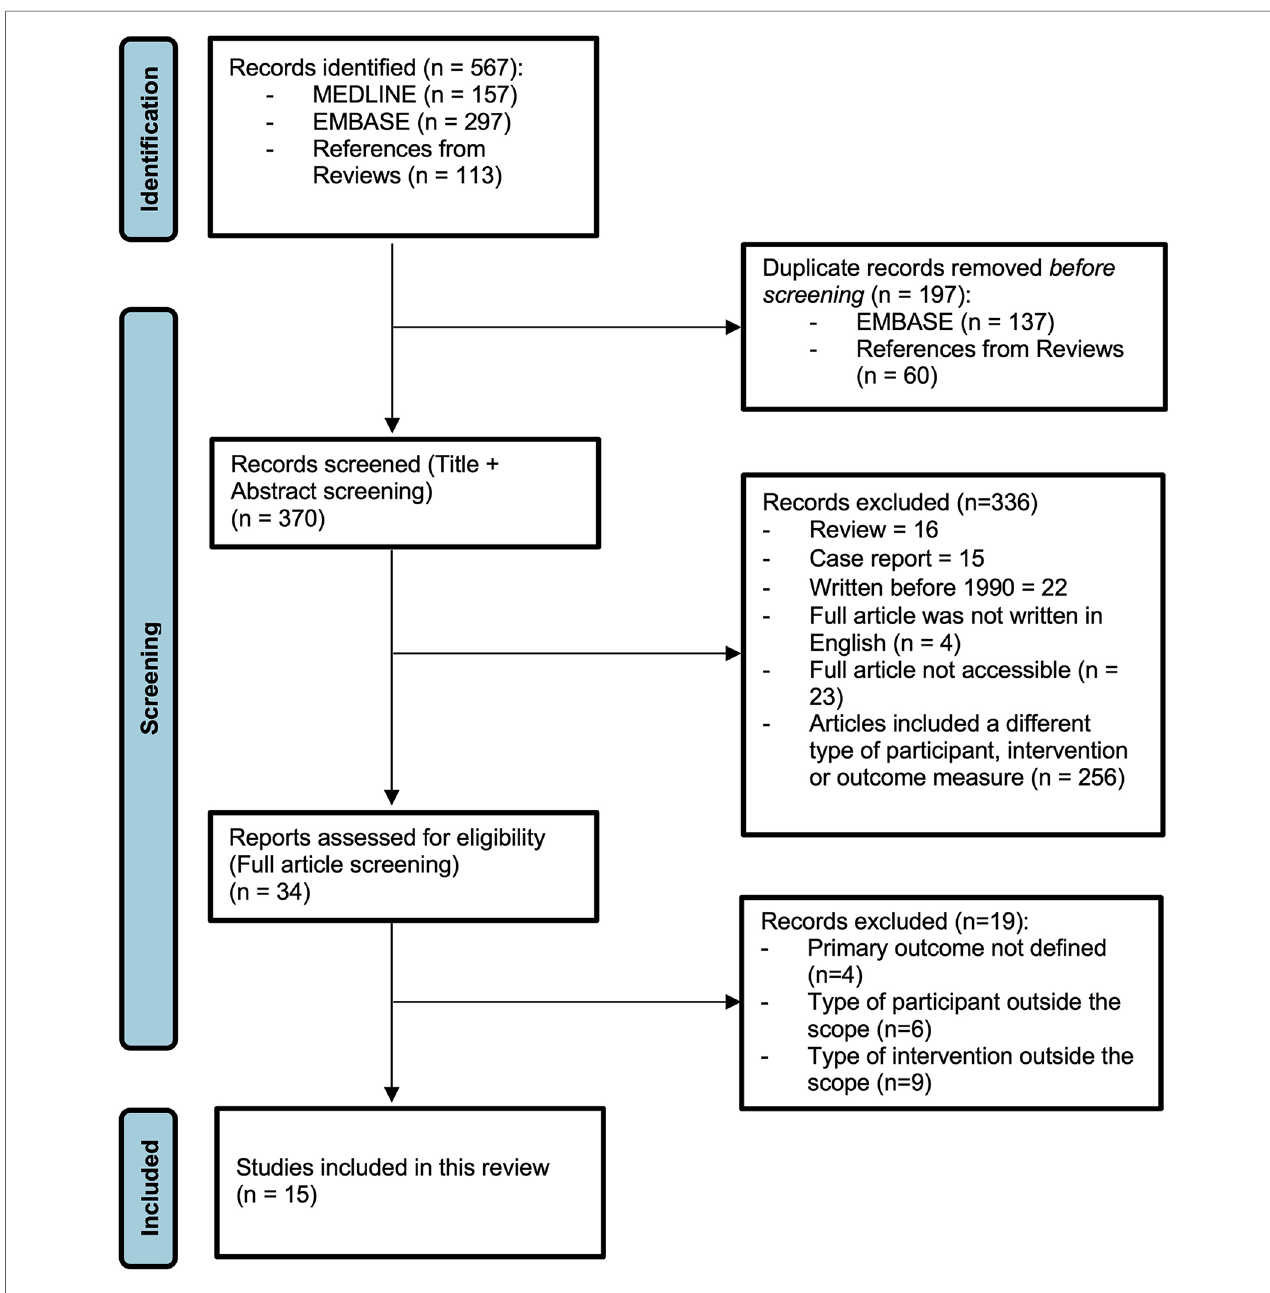
FIGURE 1 PRISMA fl ow diagram